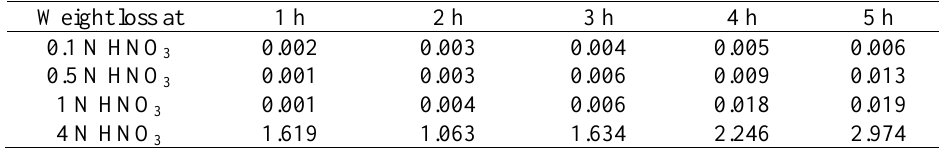
Table 12. Weight loss of Brass in H